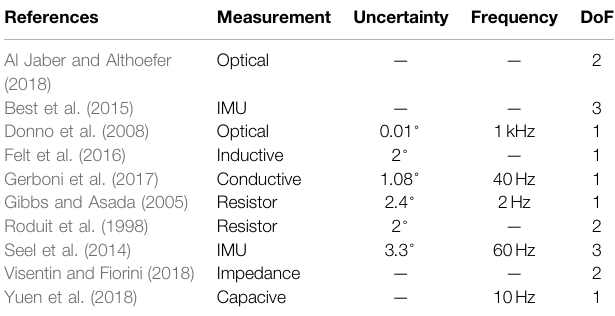
TABLE 1 | Overview of different measurement methods for the determination of actuator deformation compiled from the current